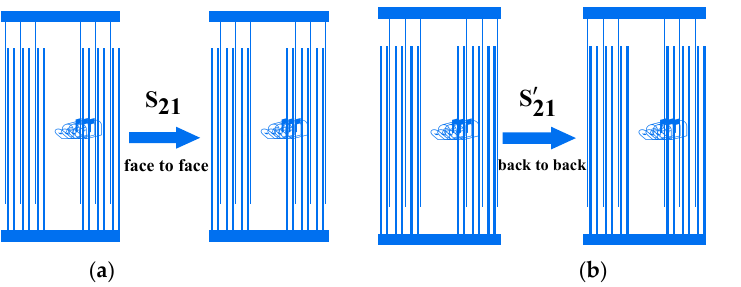
Figure 6. Test device configuration with ( a ) transducers face-to-face and ( b ) transducers back-to-back.